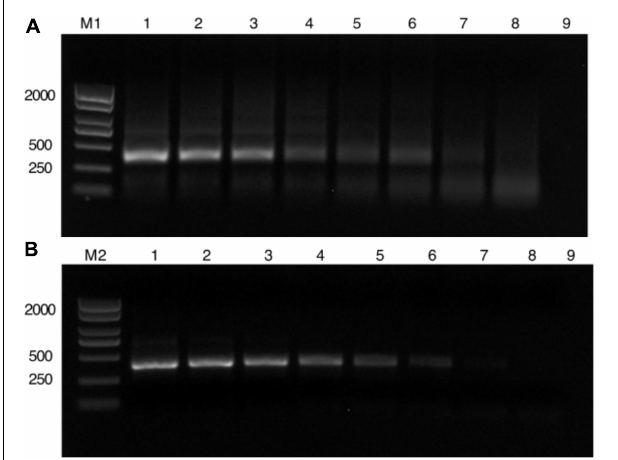
FIGURE 2 | Length of detection of PCR and RPA to detect different concentrations. (A) Different concentrations amplified by RPA. (M1) DL2000 Plus DNA Marker. (1–8) The plasmid with N segment of the TSWV were serially diluted 10-fold (2.26 × 10 8 to 2.26 × 10 1 copies/ µ l). (9) Negative control has RNase-free water as an input. (B) Different concentrations only amplified by the PCR reaction. (M2) DL2000 Plus DNA Marker. (1–8) The plasmid with N segment of the TSWV were serially diluted 10-fold (2.26 × 10 8 to 2.26 × 10 1 copies/ µ l). (9) Negative control has RNase-free water as an input. RPA, recombinant polymerase